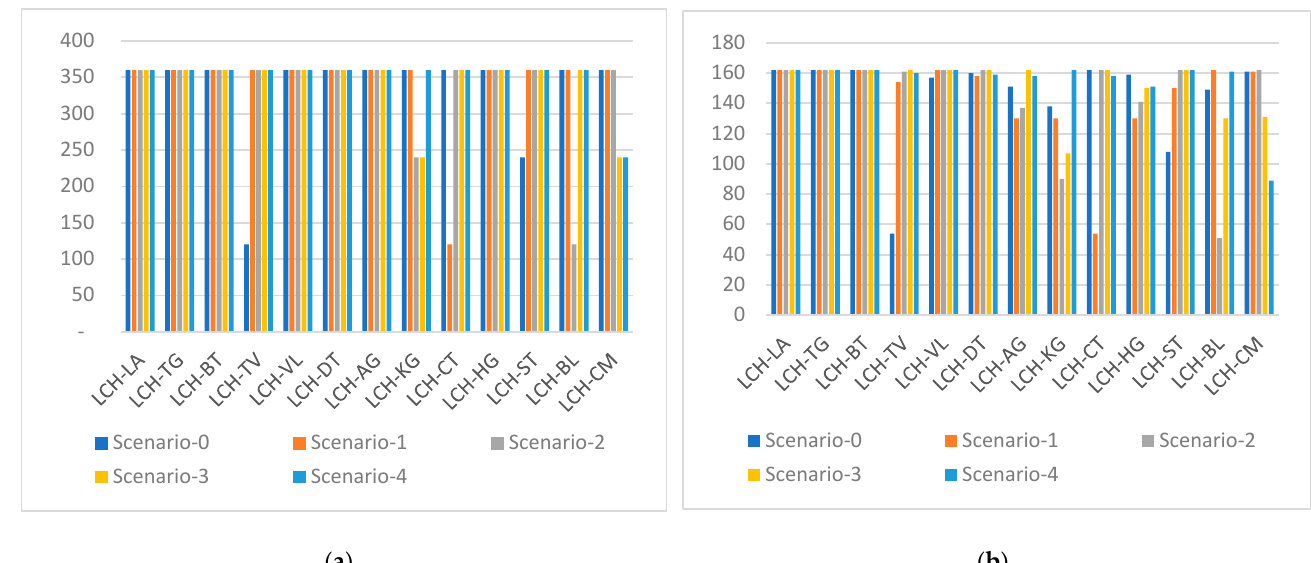
Figure 11. Scenario’s local collection hub locations. ( a ) Capacity; ( b ) workforce level.